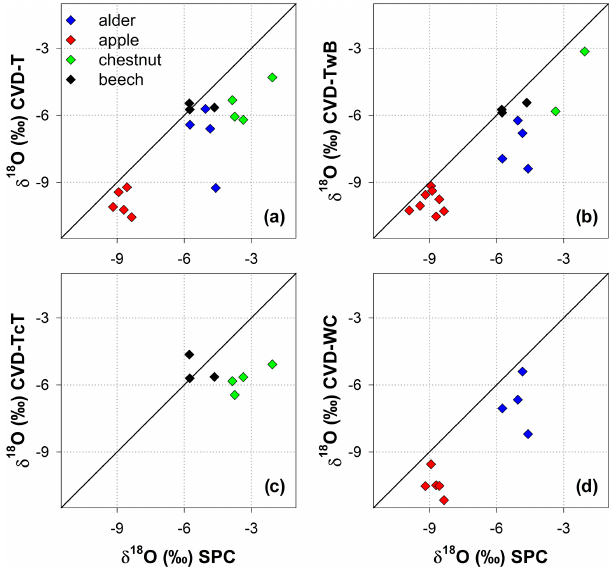
Figure 6. Relation between δ 18 O in plant water extracted by SPC (i.e., Scholander-type pressure chamber) and CVD (i.e., cryogenic vacuum distillation), grouped by plant tissue and species. The solid black lines represent y = x